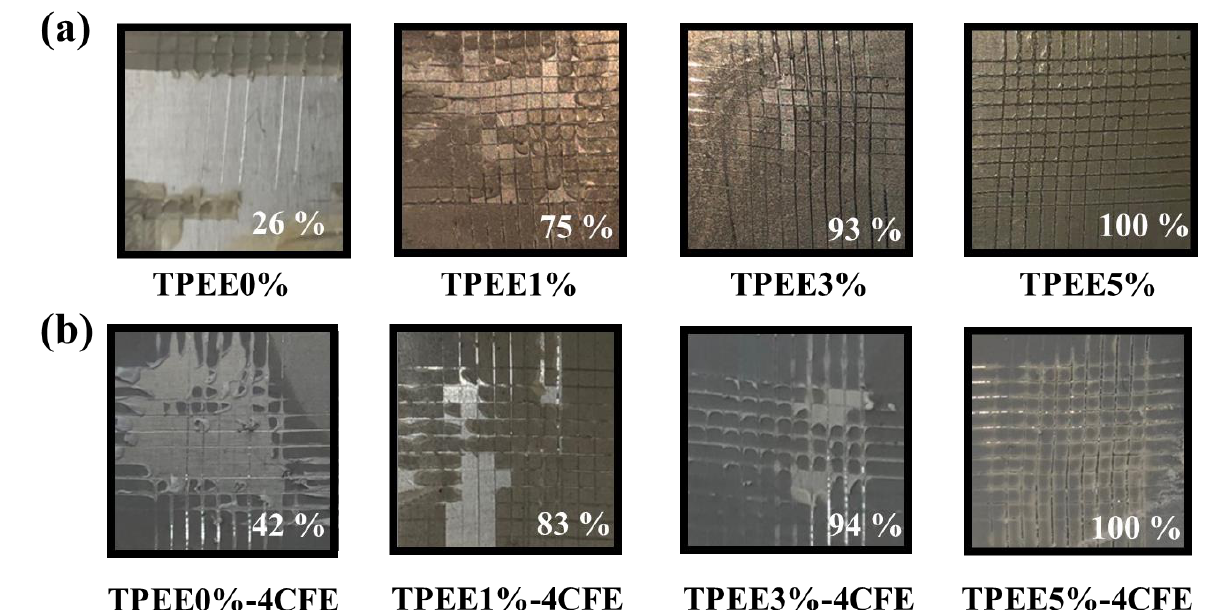
Figure 4. Adhesion testing of ( a ) TPEEn% and ( b ) TPEEn%-4CFE coated on an iron surface and treated by the cross-cut method.